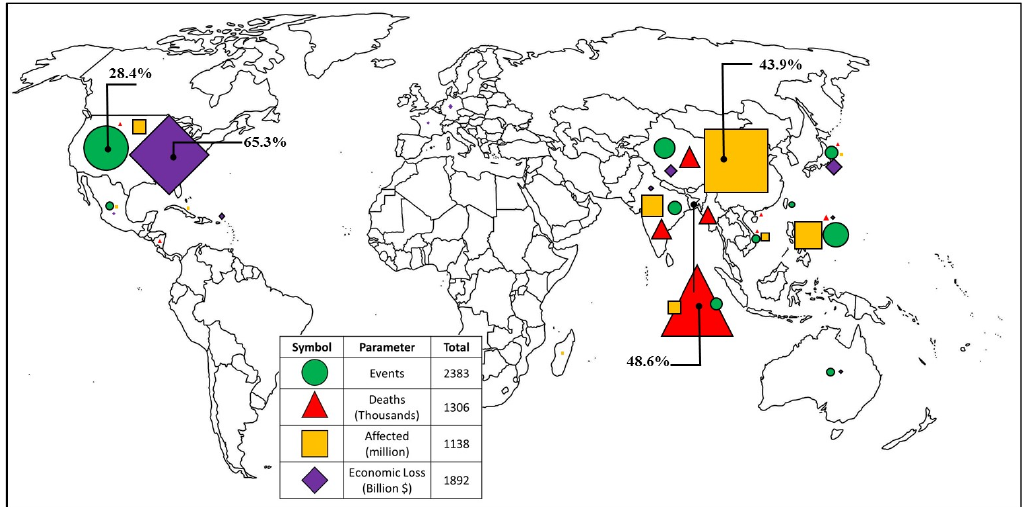
Figure 7. Global hotspots for meteorological disasters (storms only) based on data for top 10 countries in each category from 1900 to 2020 AD. (Data Source: [57]).